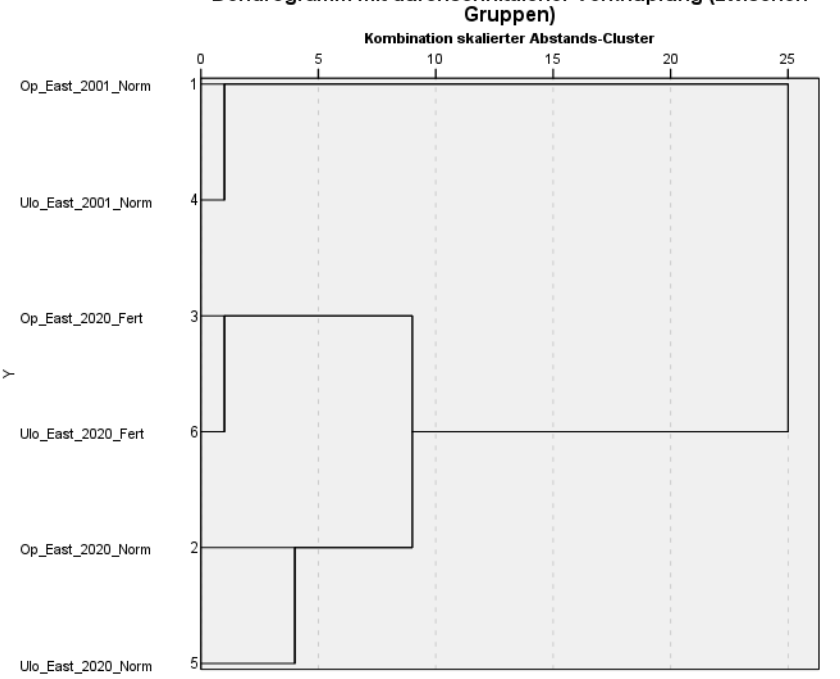
Figure 4. Dendrogram of the similarities between the eastern test plots from 2001 to 2020.